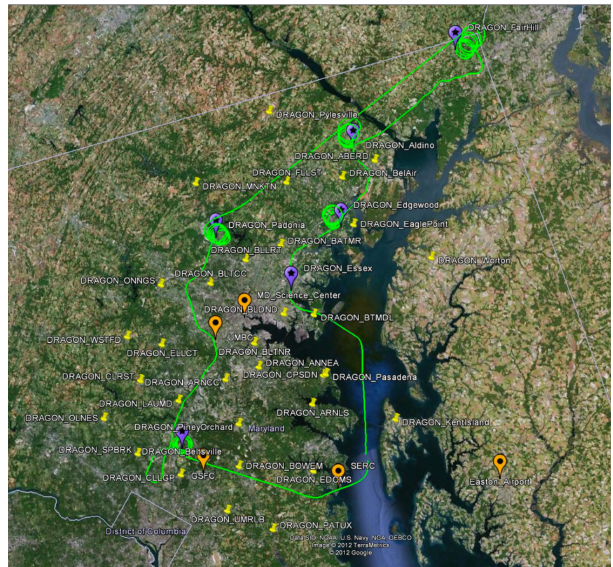
Figure 1. The DISCOVER-AQ Maryland July 2011 field experi- ment region is shown. The yellow, orange and purple markers de- note the location of AERONET sun–sky radiometer sites, mostly as DRAGON field campaign deployments. A typical flight circuit of the NASA P3-B aircraft is depicted in green with spiral profiles made over principal ground-instrumented sites.